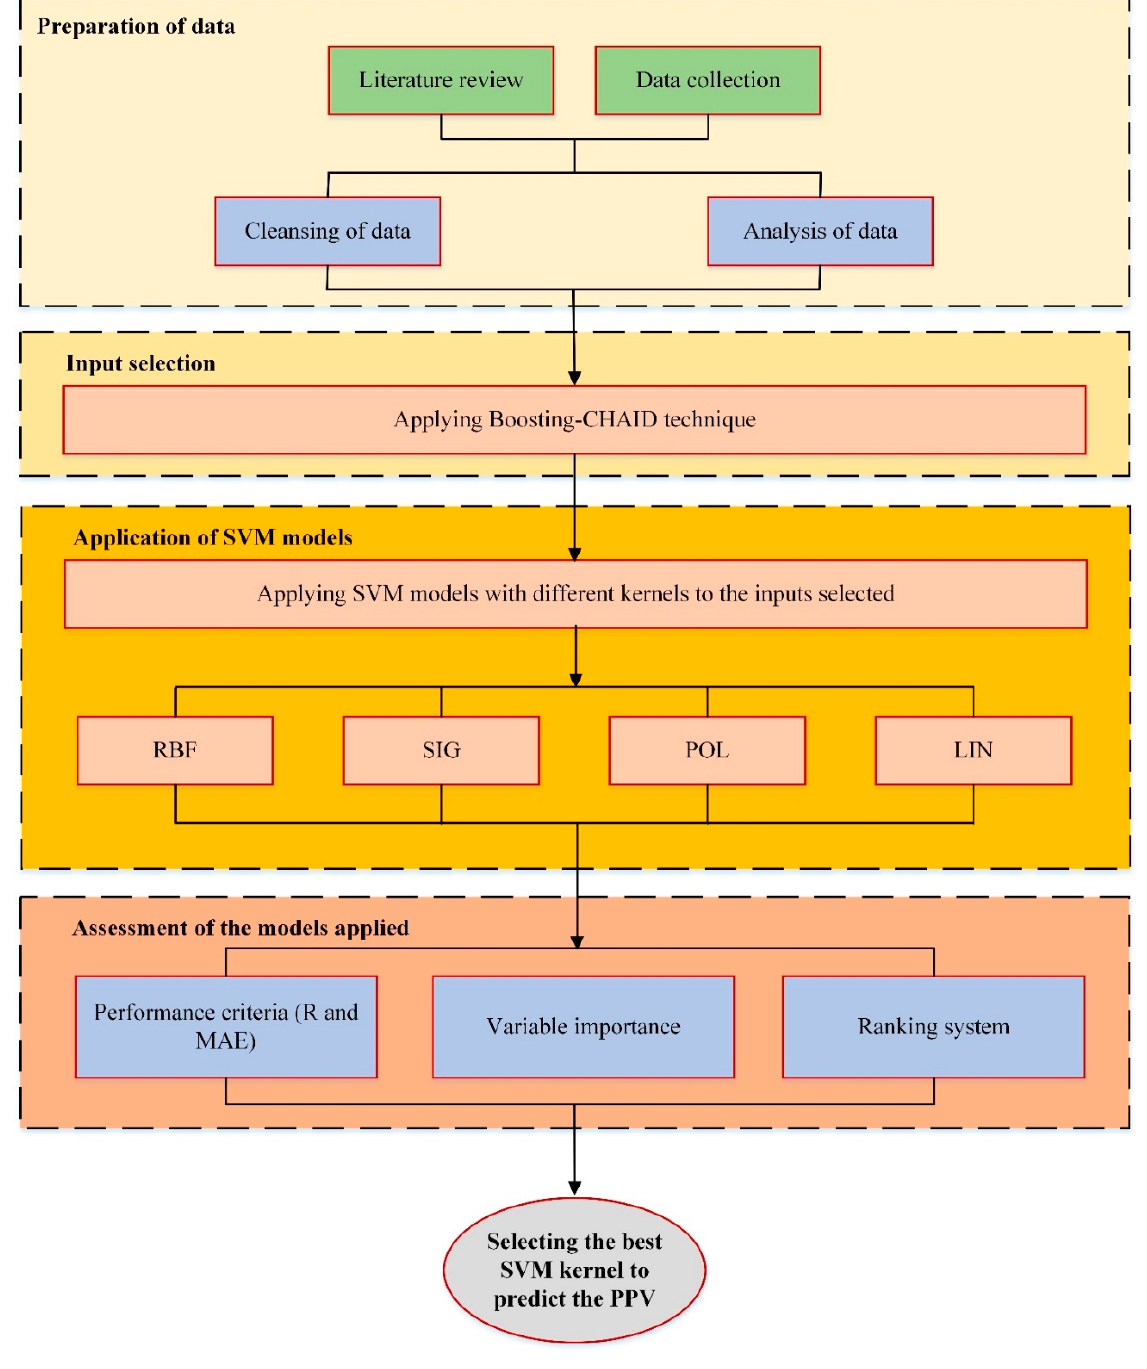
Figure 1. A systematic flowchart of this study.